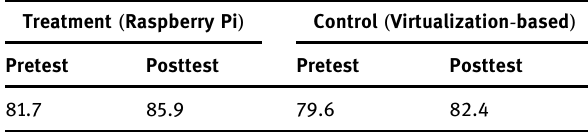
Table 3: Summary of job sheet evaluation for the pretest and posttest scores in the treatment and control groups Treatment ( Raspberry Pi )